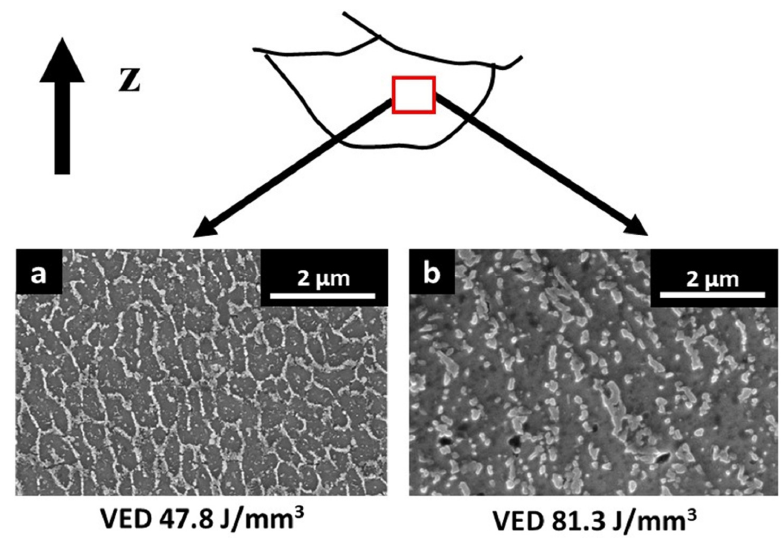
Figure 3. Schematic melt pool representation along building direction, pointing out the position of the FESEM images of ( a ) fine cellular structures for the AlSi10Mg alloy built using the standard parameters; ( b ) cellular structure not continuous of the nanocomposites built using the selected parameters to generate dense samples (after etching with Keller’s reagent).